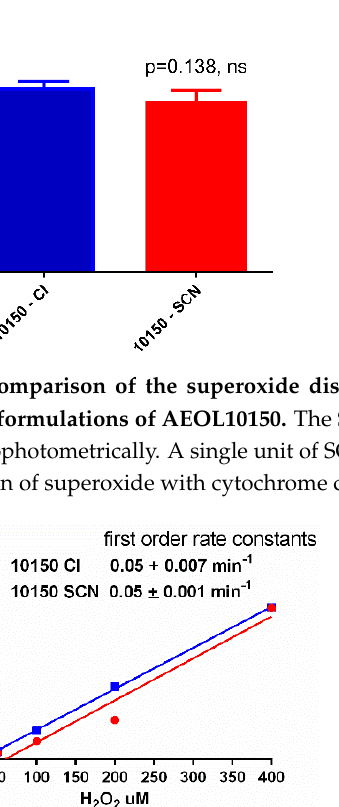
data also suggest that hypothiocyanous acid (HOSCN) was formed in the reaction.